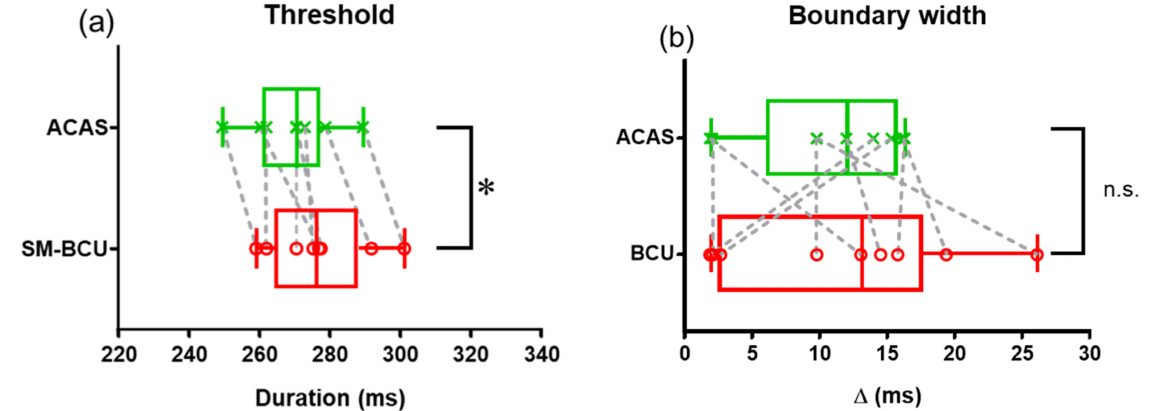
Figure 4. Threshold ( a ) and boundary width ( b ) for ACAS and SM-BCU. The asterisk indicates a statistically significant result from the Wilcoxon matched-pairs signed rank test (* p < 0.05). ACAS, air-conducted audible sound; SM-BCU, speech-modulated bone-conducted